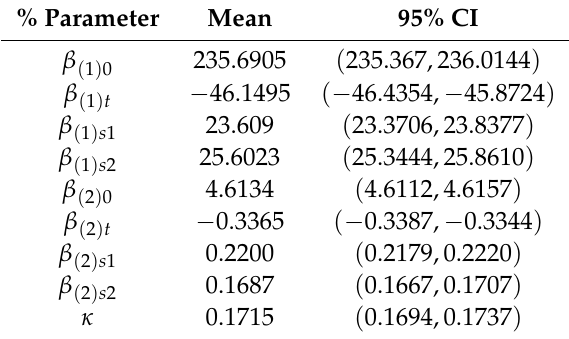
Table 3. Estimates and 95% credible intervals of the nonstationary GEV model for the PM 10 maxima.